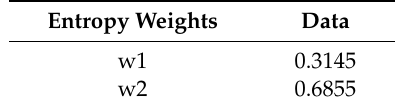
Table 3. Entropy weight of objective functions.